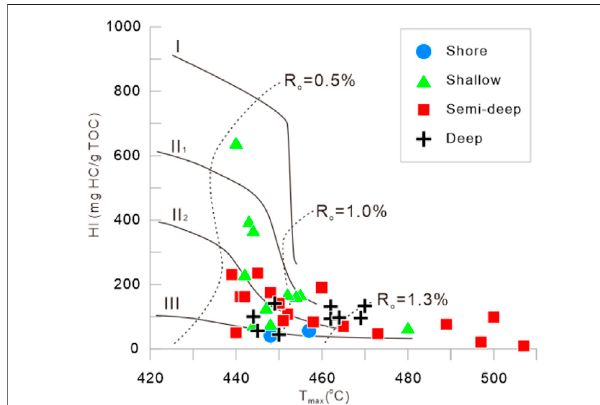
FIGURE 8 | Cross plot of hydrogen index (HI) with T max for black shale samples of the Dongyuemiao member.